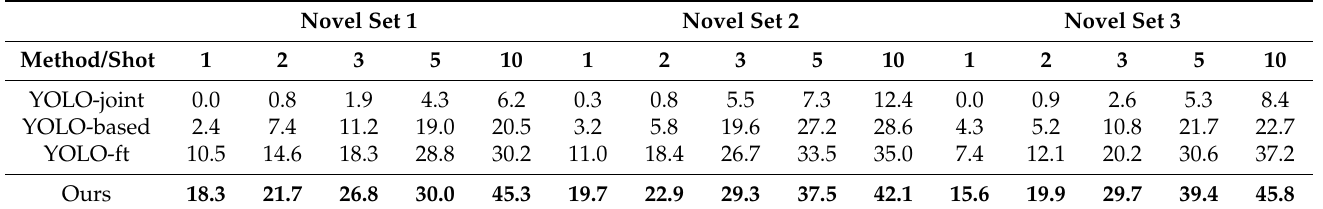
Table 2. Few-shot detection mAP on TT100K test set for novel classes. The baselines are evaluated using three separate sets of novel classes.